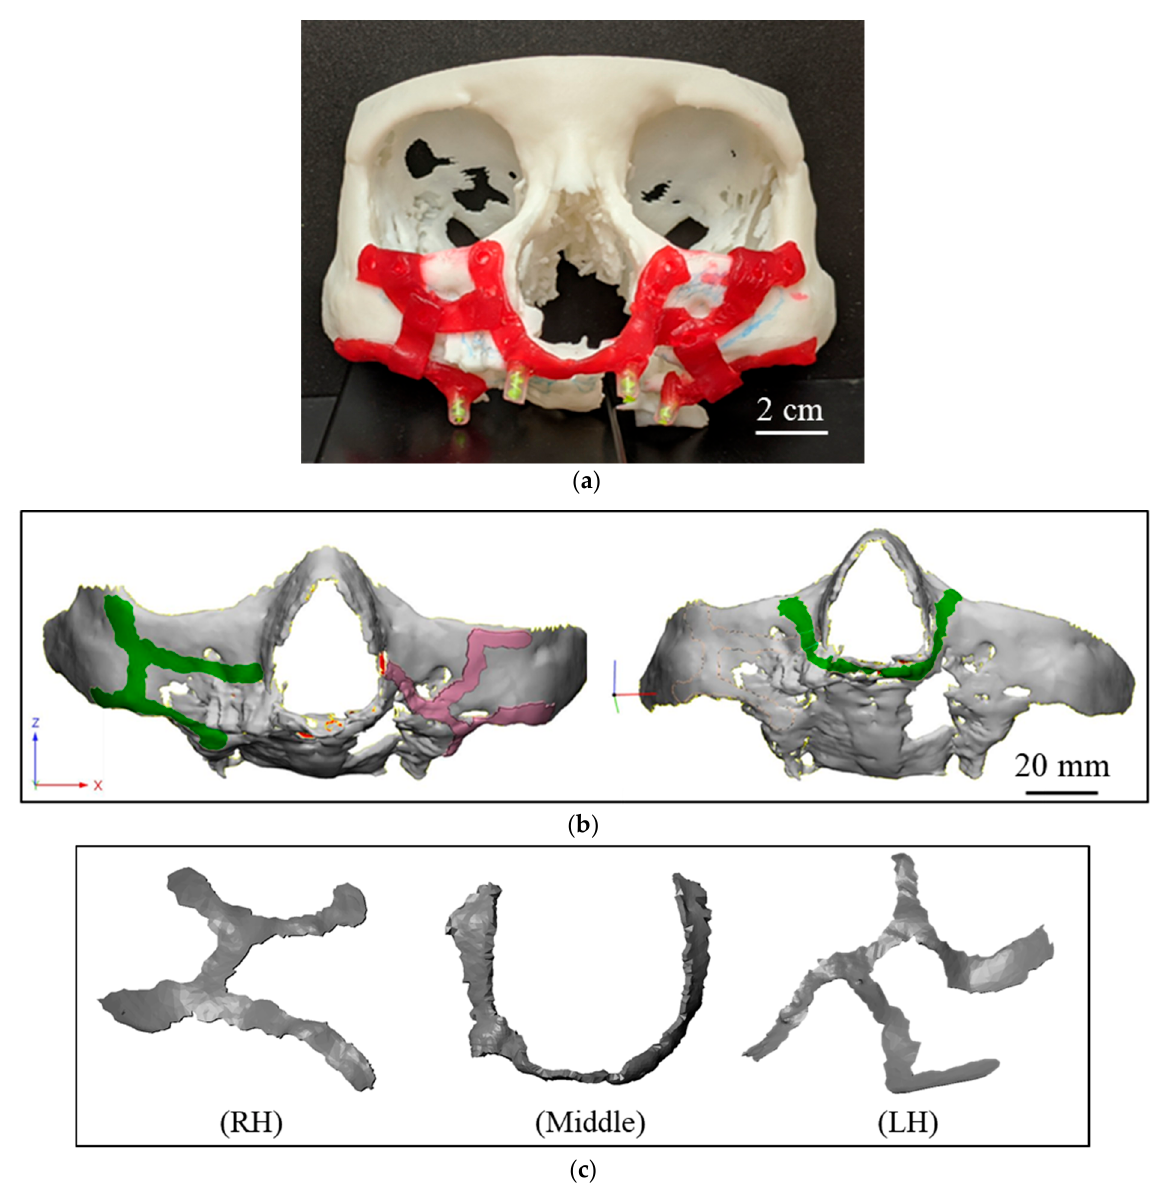
Figure 3. ( a ) Implant design requirement defined by oral/ maxillofacial surgeons considering the current condition of the patient’s maxilla structure bone and dental implant requirements. ( b ) Implant geometries generated from digital biomodel using 3-Matic. ( c ) First-generation design of the implant. The implant was divided into three components, (RH, Middle, and LH parts).